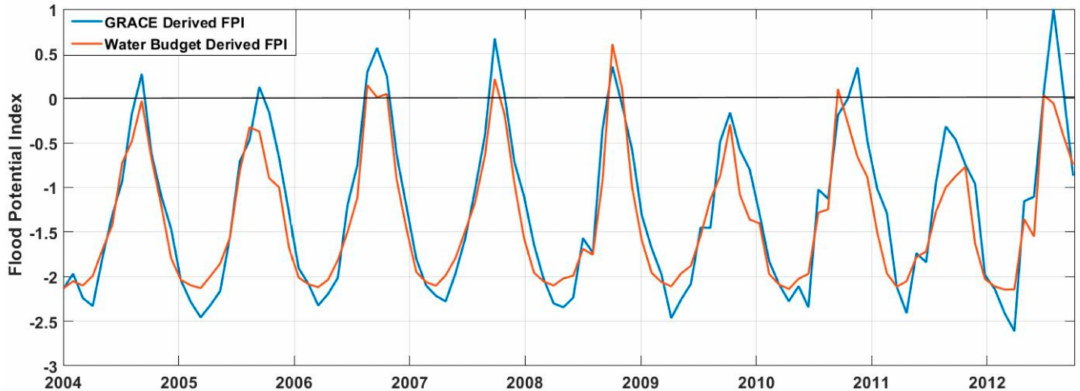
Figure 12. Graphical comparison and validation of FPI from GRACE using the FPI from water budget